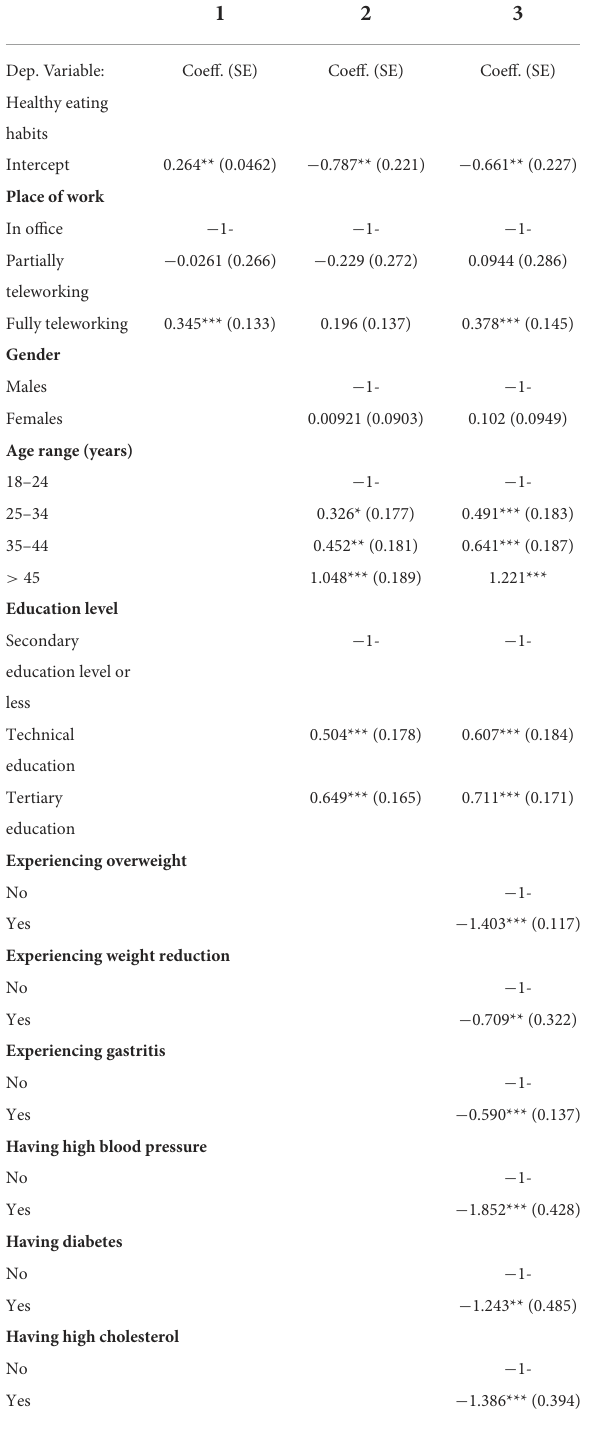
TABLE 3 Regression analysis for having healthy eating habits by considering 3 sub-sets of variables: place of work (Logit model 1), place of work, age and education level (Logit model 2), place of work, age, education, weight status, and health conditions (Logit model 3).